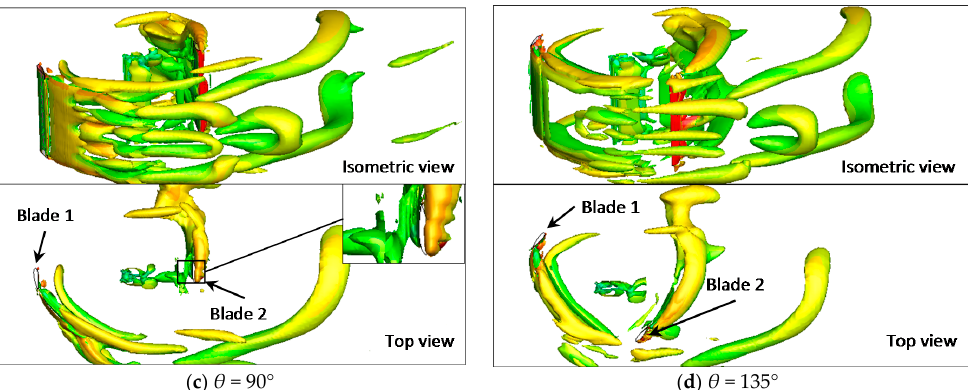
Figure 6. Q -criterion iso-surface of vortex structure for rotor with the azimuth angle of ( a ) θ = 0°, ( b ) θ = 45°, ( c ) θ = 90° and ( d ) θ = 135° at TSR = 1.38. Contour of Q -criterion iso-surface depicts the wind velocity of U .